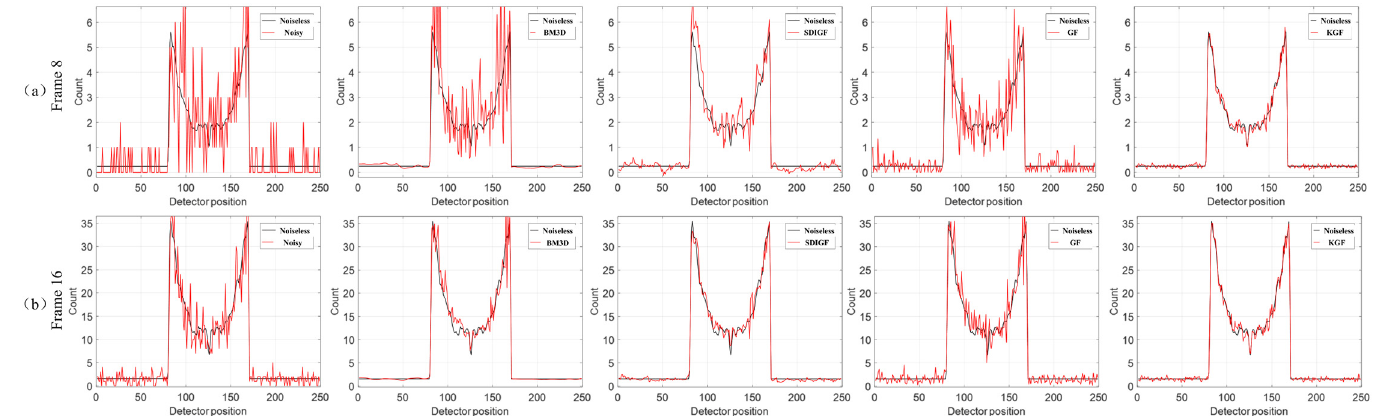
Fig 3. Single angle curves of the sinograms denoised by different methods for Frame 8 and Frame 16. Black line is noiseless sionogram cruve. The columns correspond to noisy sinogram and sinograms denoised by BM3D, SDIGF, GF and KGF (left to right).